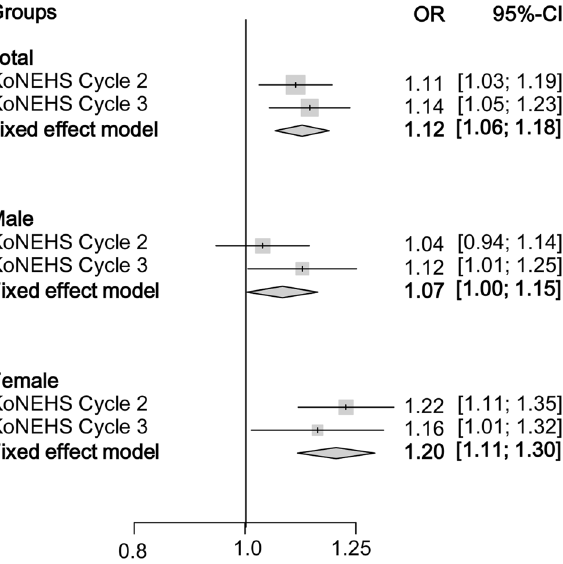
Figure 1. Meta-analysis with data from KoNEHS Cycle 2 and Cycle 3: odds ratios for obesity in males and females. Values were adjusted for age, sex, household income, smoking, alcohol consumption, and physical